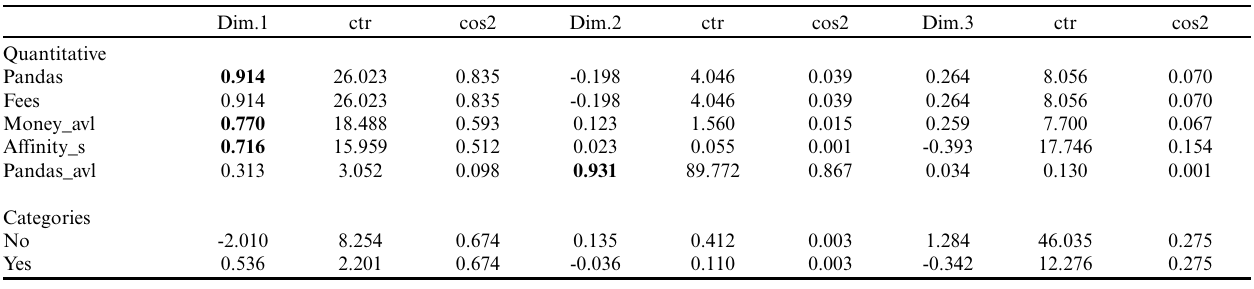
Table 3 . Leading factors behind panda loans: coordinates, contribution (ctr), squared-cosine (cos2) for each of the first three extracted dimensions (Dim.) by the factor analysis for quantitative and categorical variables. Pandas: number of pandas loaned. Fees: fees paid. Money_avl: money availability. Affinity_s: social affinity. Pandas_avl: panda availability; i.e., total number of pandas available for loan. Categories represent political will (yes–no).